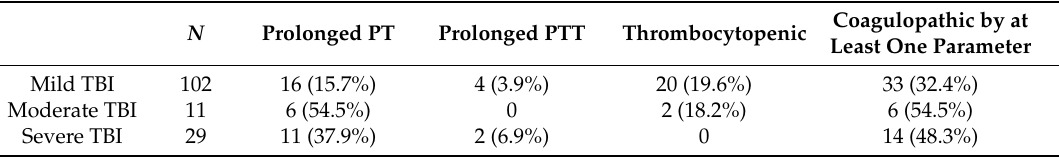
Table 3. Coagulopathy by prothrombin time (PT), partial thromboplastin time (PTT), and international normalized ratio (INR) in all TBI patients